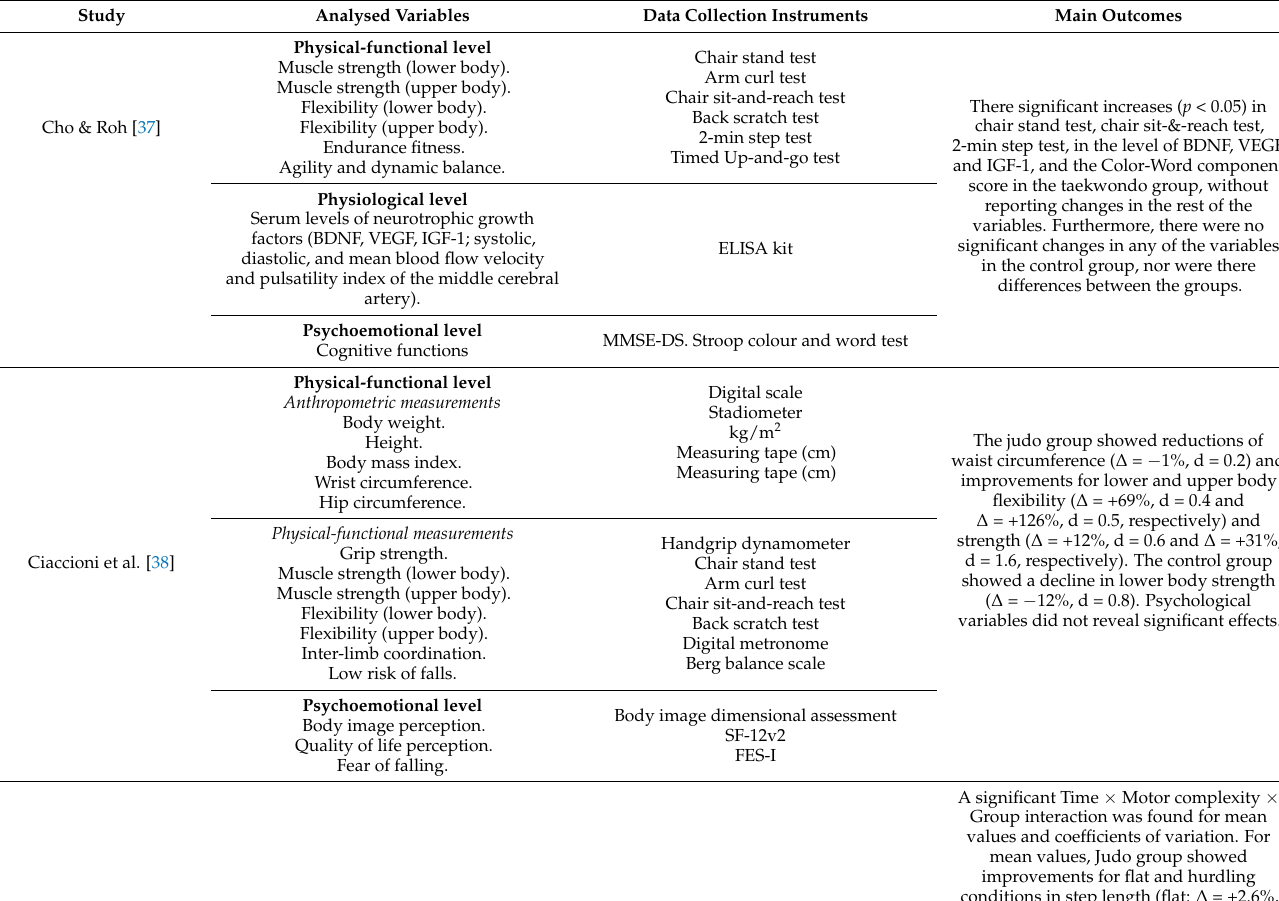
Table 3. Effects reported by studies with Olympic combat sports on older adults’ health